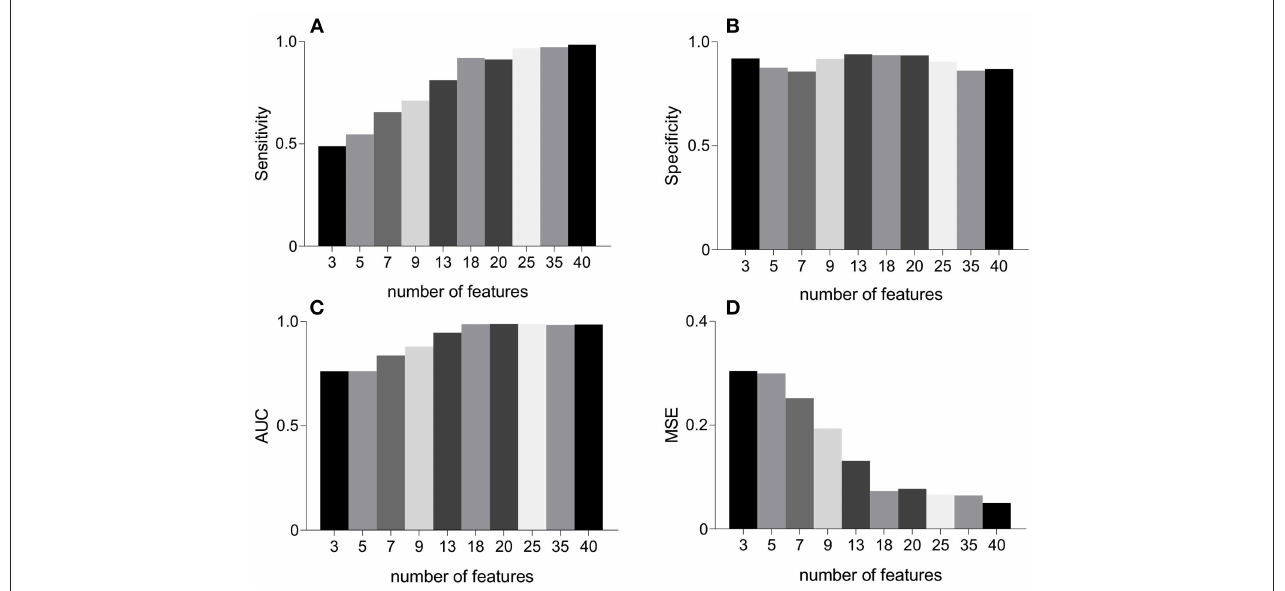
FIGURE 5 | An illustration of performance measures for the RFE feature selection scheme. Panel (A) represents sensitivity, (B) represents specificity, (C) represents AUC, and (D) represents MSE. AUC, area under the ROC curve; MSE, mean squared error; RFE, recursive feature elimination.